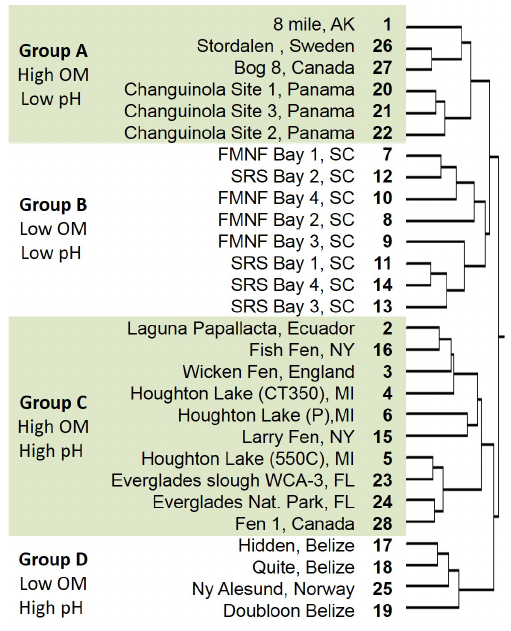
Figure 1. Wards hierarchical classification of 28 palustrine wet- lands used to delineate four types of wetland (A–D) based upon organic matter (OM) content and pH. Francis Marion National For- est (FMNF), Savanah River Site